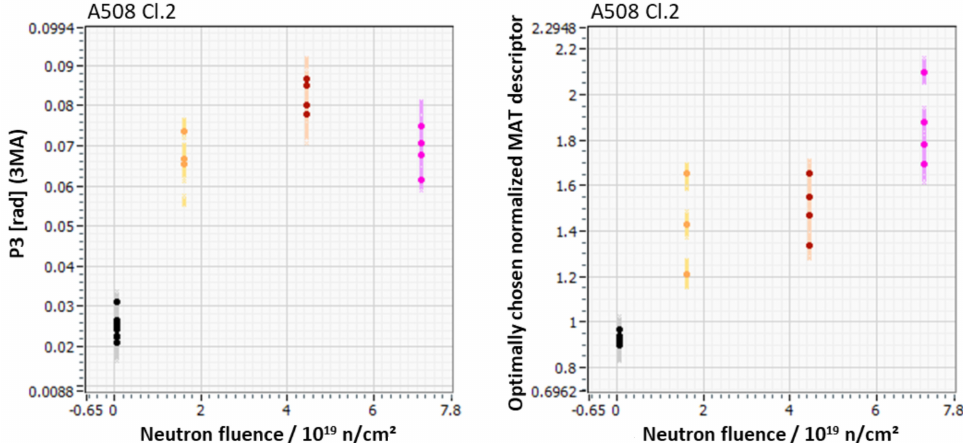
Figure 11. Dependency of the amplitude of third harmonics P3 ( left ) and of the magnetic adaptive testing (MAT) descriptor ( right ) on the fluence level for western reactor pressure vessel (RPV) material A508